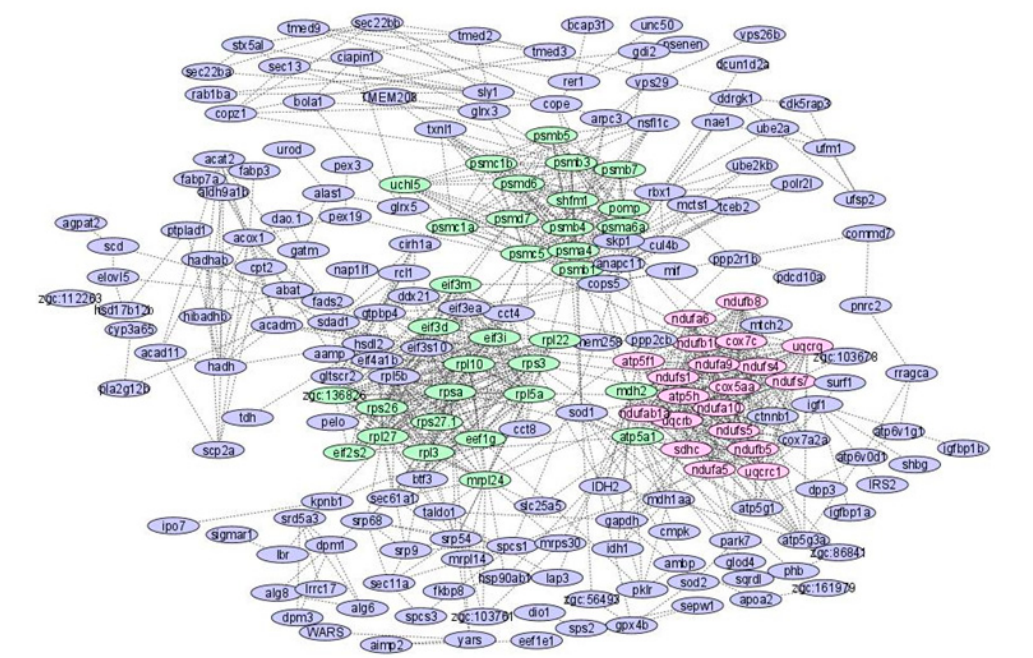
Figure 2. PPI network derived from DEGs affecting starvation in zebrafish.